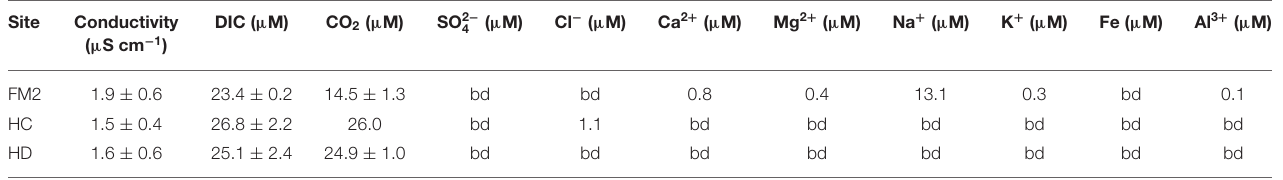
TABLE A1 | The chemical composition of MilliQ de-ionized water in the control bottles at 168 h. Site